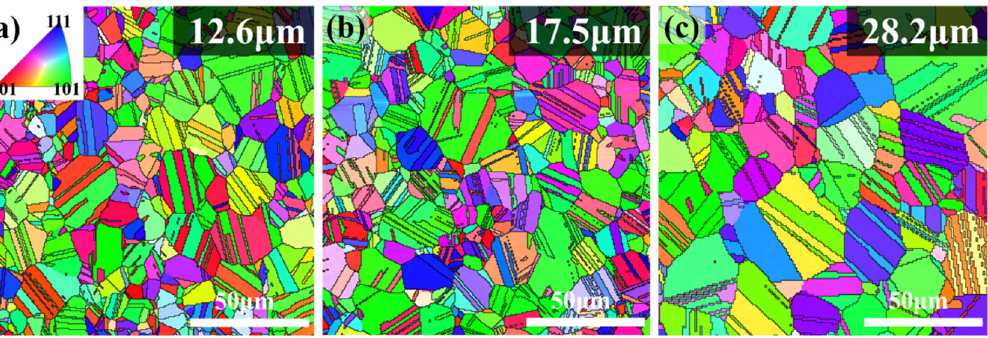
Figure 2. EBSD IPFz maps of the 900 °C-annealed CoCrNiSi 0.3 MEA. ( a ) 15-min, ( b ) 30-min, ( c ) 60- min. ( c )